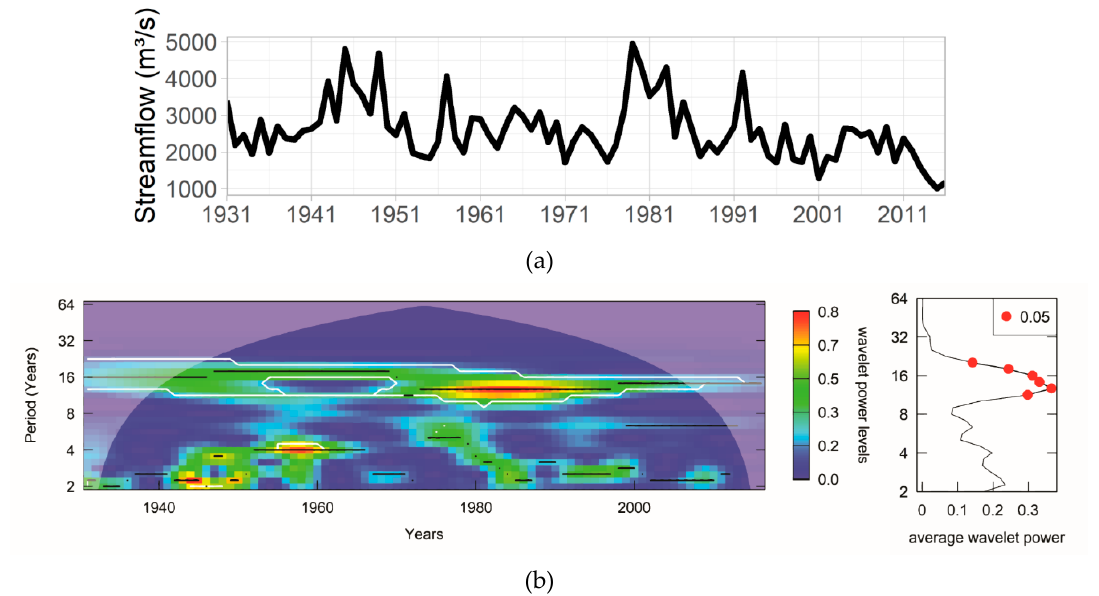
Figure 3. ( a ) Annual streamflow time series of the Sobradinho reservoir; ( b ) the wavelet power spectrum and the average wavelet power over that period. Water 2020 , 12 , x FOR PEER REVIEW